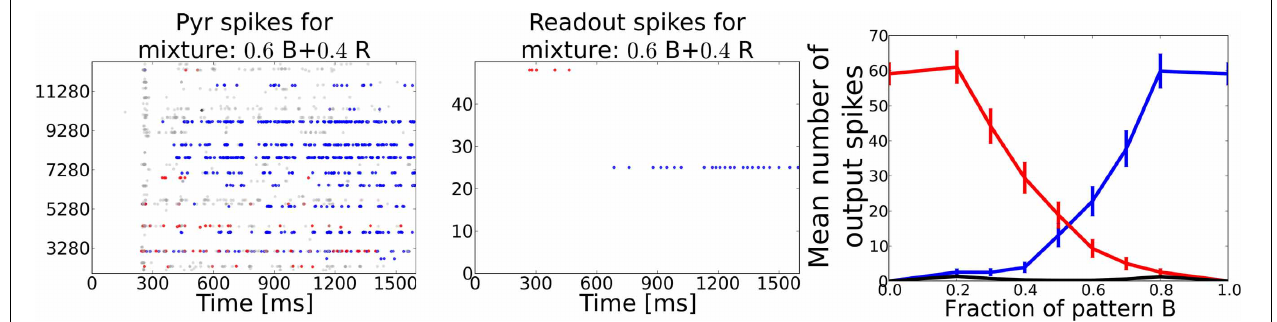
FIGURE 7 | Task 5: Pattern rivalry with sniffing input. Left: Raster plot showing PYR responses to a 0 . 6 / 0 . 4 mixture of two distinct patterns. The fraction of both patterns stays constant during the whole stimulation. Blue dots show spikes from cells being active during the “blue” odor in Task 1. Red dots show spikes from cells being active during the “red” odor in Task 1. Gray dots show spikes from cells that are active during the test pattern, but have not been active in either of the two mixture components. During the first 200ms the red pattern evokes activity in both PYR and readout cells, but is then suppressed by the blue pattern becoming active after ∼ 500ms of odor stimulation. A substantial part of PYR activity is related to none of the two patterns, exemplary for the